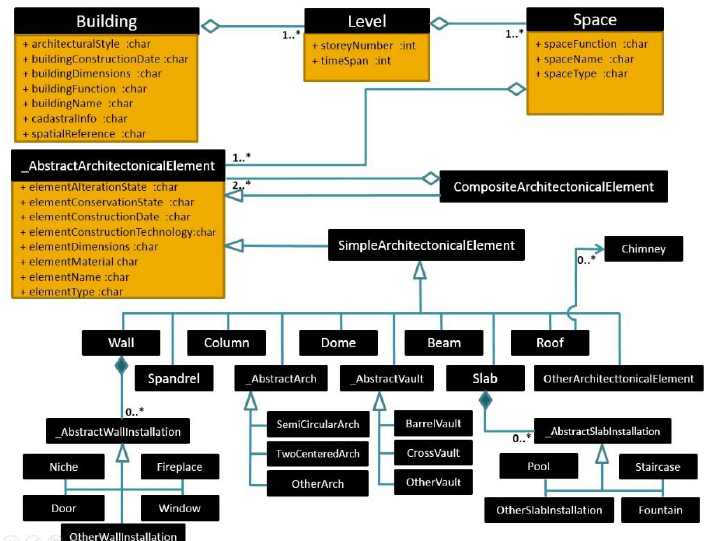
Figure 7. UML diagram representing classes and relations among the components of a historical